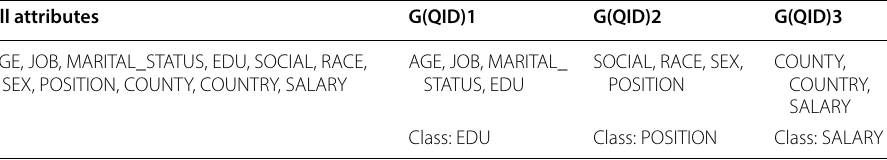
Table 3 Adult dataset and G(QID) groups used in the below experiments All